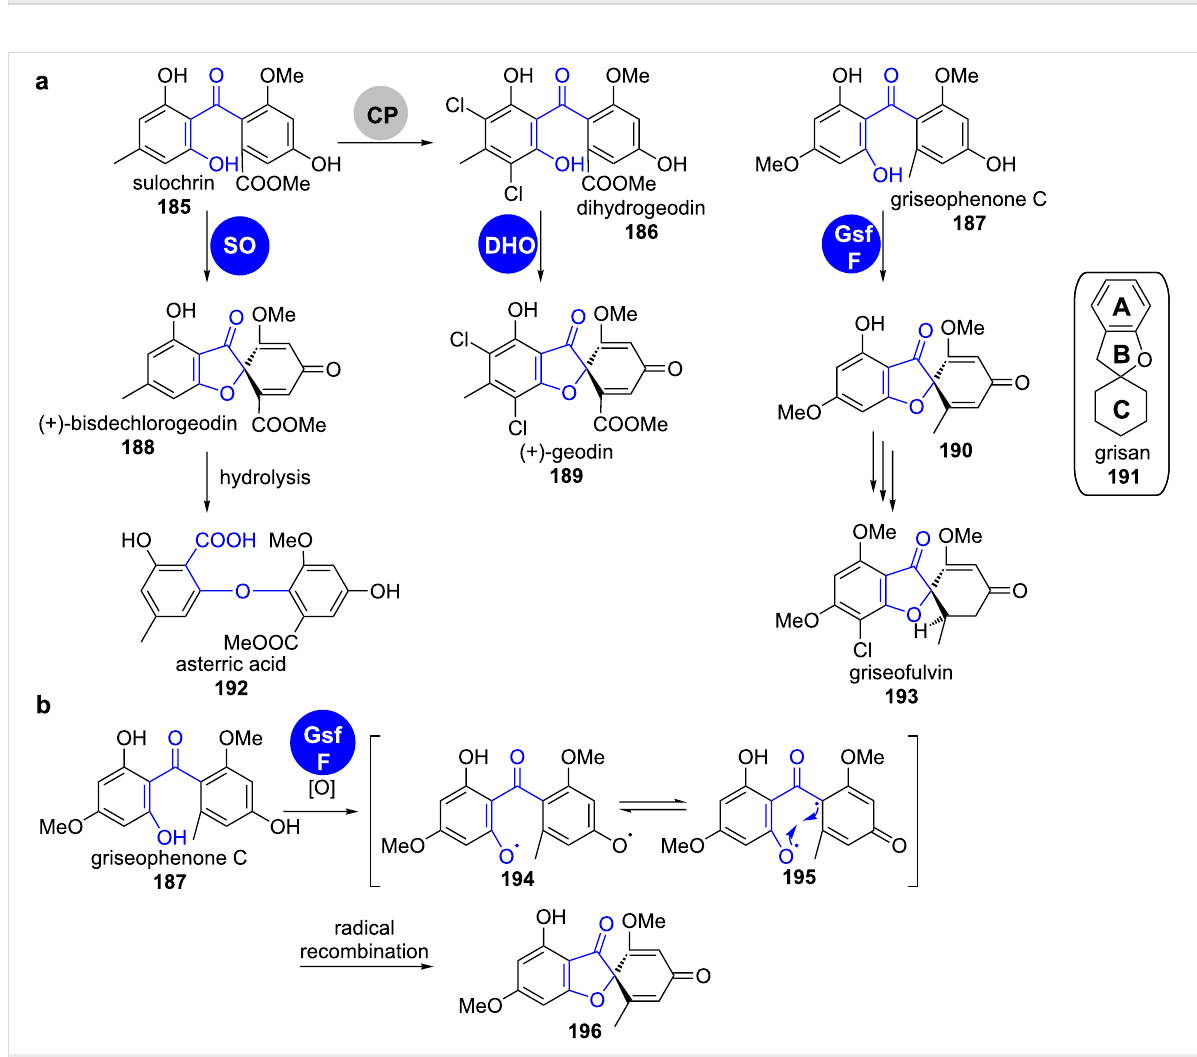
Scheme 26: a) Oxidative cyclisation is a key step in the biosynthesis of spirobenzofuranes 189 , 192 and 193 . b) Mechanism of the proposed cytochrome P450-catalysed stereospecific radical coupling in the biosynthesis of griseofulvin ( 193 ). CP: chloroperoxidase; SO: sulochrin oxidase; DHO: dihydrogeodin oxidase